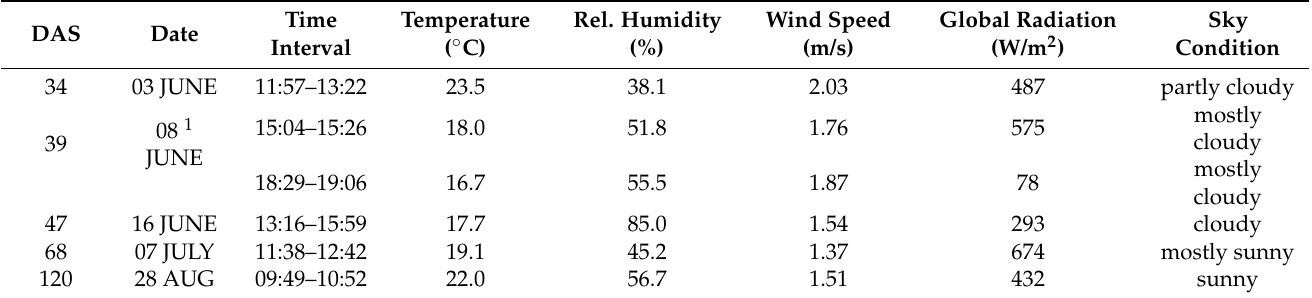
Figure 1. Overview of the maize field trial for UAV-based plant height estimation. ( a ) RGB orthomo- saic with the 400 relevant plots highlighted in green; ( b ) soil elevation of the 400 plots as received from the flight on DAS 34. The arrow indicates the north; masl: Meter above sea level. Table 1. Weather conditions during the UAV flights; DAS: days after